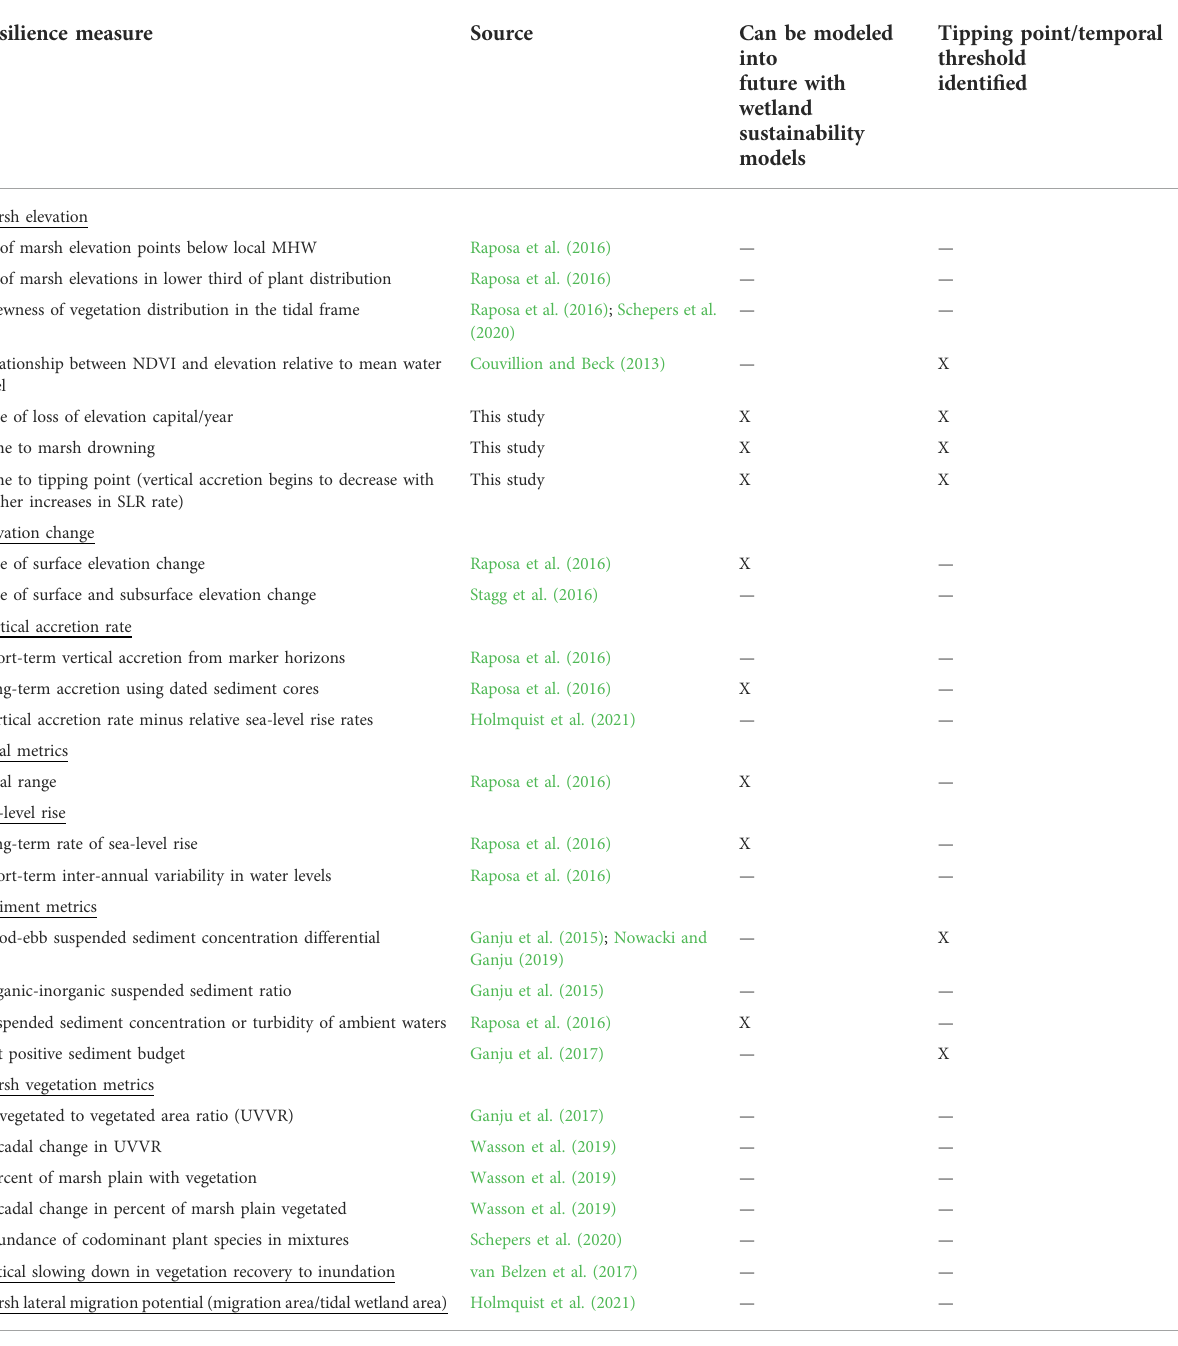
TABLE 1 Compendium of individual metrics used to assess tidal marsh resilience to